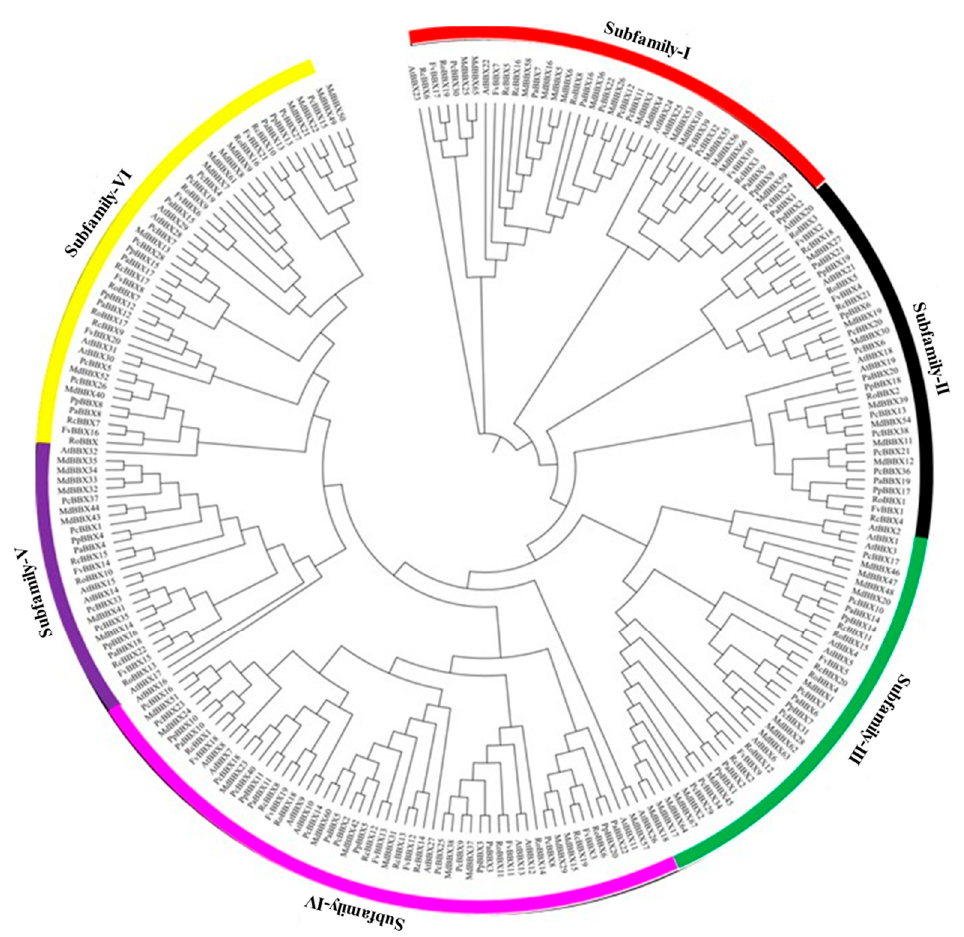
Figure 4. Systematic evolutionary relationships of BBX gene family 7 different Rosaceae species among six lineages within the subfamilies. The six conserved subfamilies are marked by different colors and represented as Subfamily-I, Subfamily-II, Subfamily-III, Subfamily-IV, Subfamily-V, and Subfamily-VI.